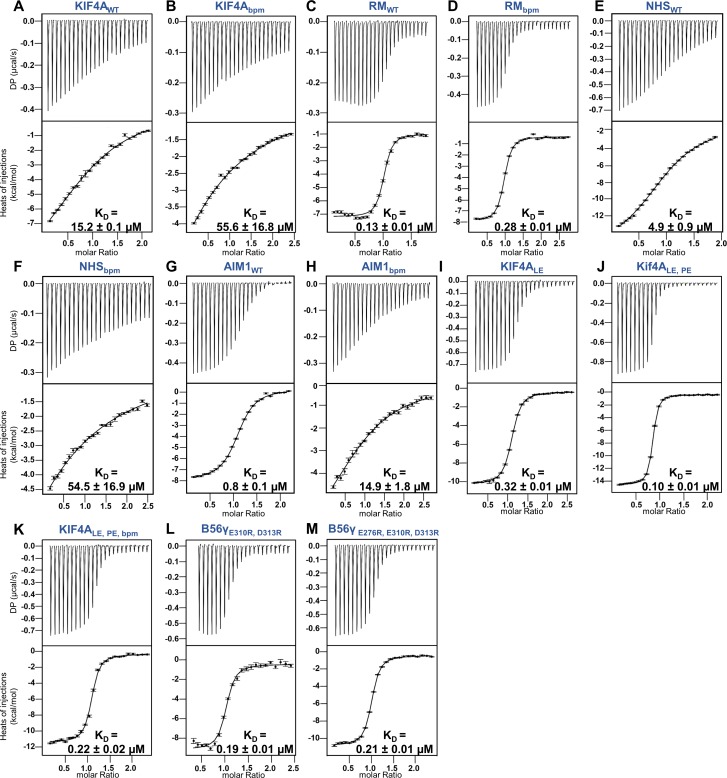
ITC thermograms for various PP2A-B56 interactors (WT and bpm) with B56γ (WT and acidic patch mutants).(A) ITC data for B56WT with KIF4AWT(1192–1232). (B) ITC data for B56WT with KIF4Abpm(1192–1232; 1208KKK1210 to AAA). (C) ITC data for B56WT with RepoMan (533-603; RM). (D) ITC data for B56WT with RMbpm(533–603, 563RKKK566 to AAAA). (E) ITC data for B56WT with NHS (1616–1635). (F) ITC data for B56WT with NHSbpm(1616–1635, 1618RCR1620 to AAA). (G) ITC data for B56WT with AIM1 (716–741). (F) ITC data for B56WT with AIM1bpm (716-741; 716KRKKAK721 to AAAAA). (I) ITC data for B56WT with KIF4ALE(1192–1232; 1224CS1225 to LE). (J) ITC data for B56WT with KIF4ALE,PE(1192–1232; 1224CS1225 to LE, 1231AH1232 to PE). (K) ITC data for B56WT with KIF4ALE,PE, bpm(1192–1232; 1224CS1225 to LE, 1231AH1232 to PE, 1208KKK1210 to AAA). (L) ITC data for B56γ2R (E310R/D313R) with KIF4ALE,PE. (M) ITC data for B56γ3R (E276R/E310R/D313R) with KIF4ALE,PE.